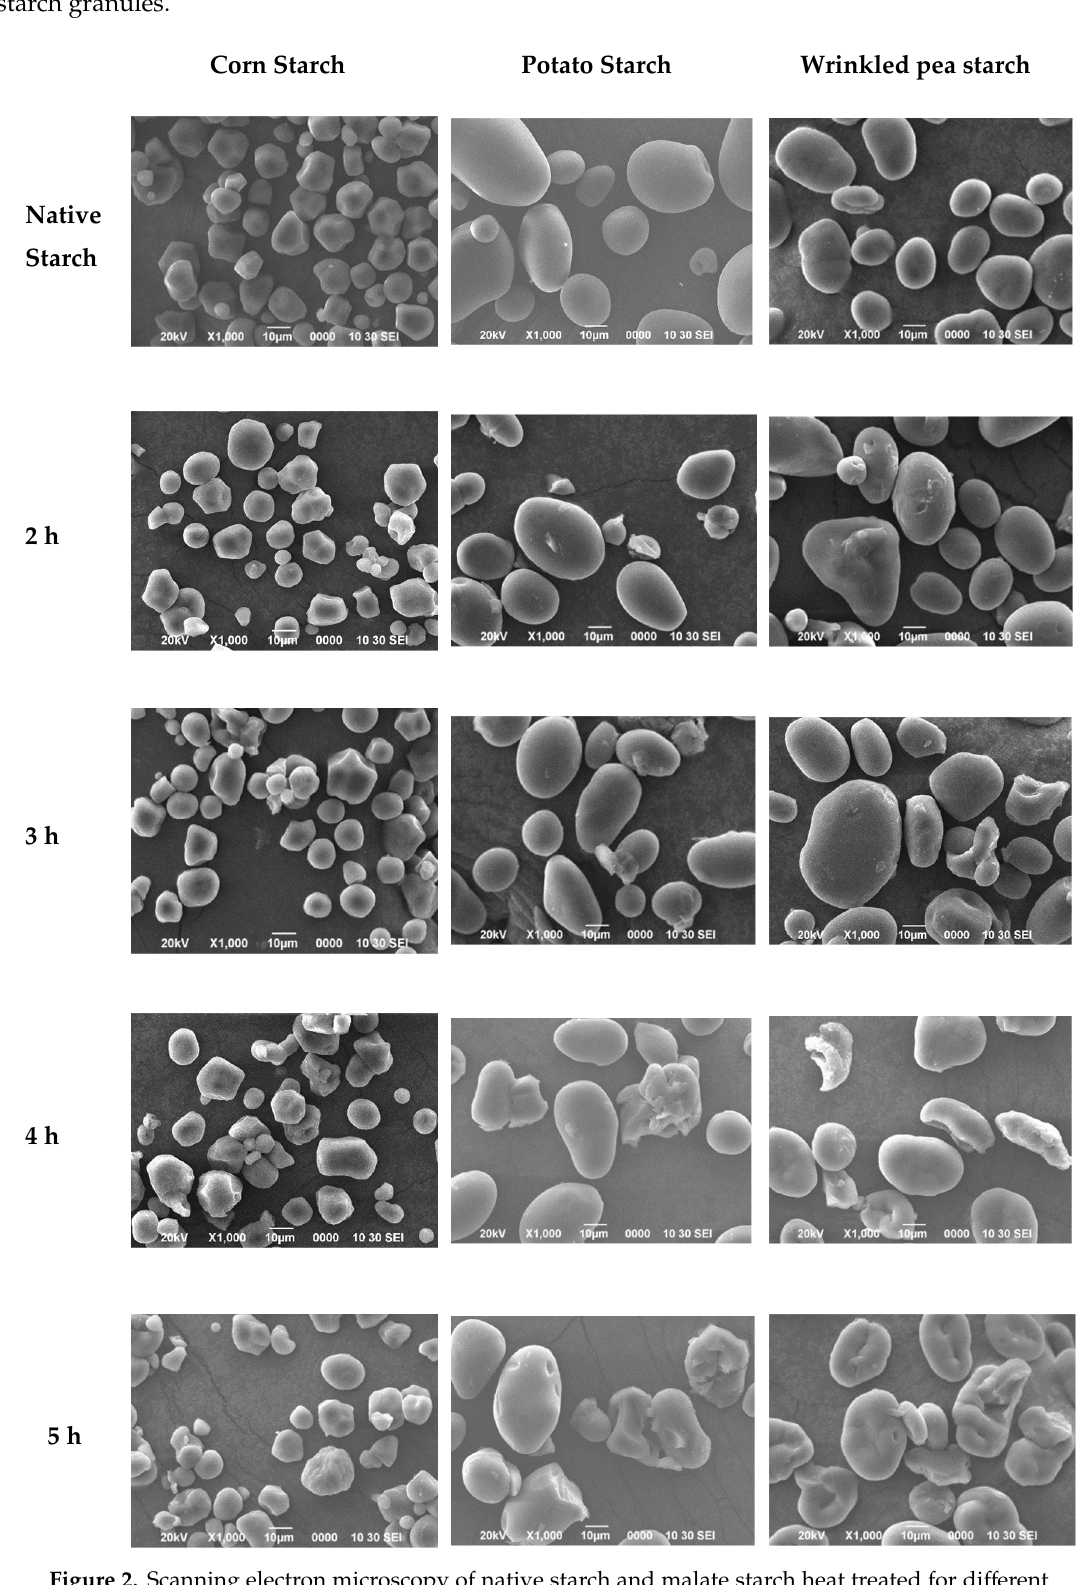
Figure 2. Scanning electron microscopy of native starch and malate starch heat treated for different lengths of time (1000×).